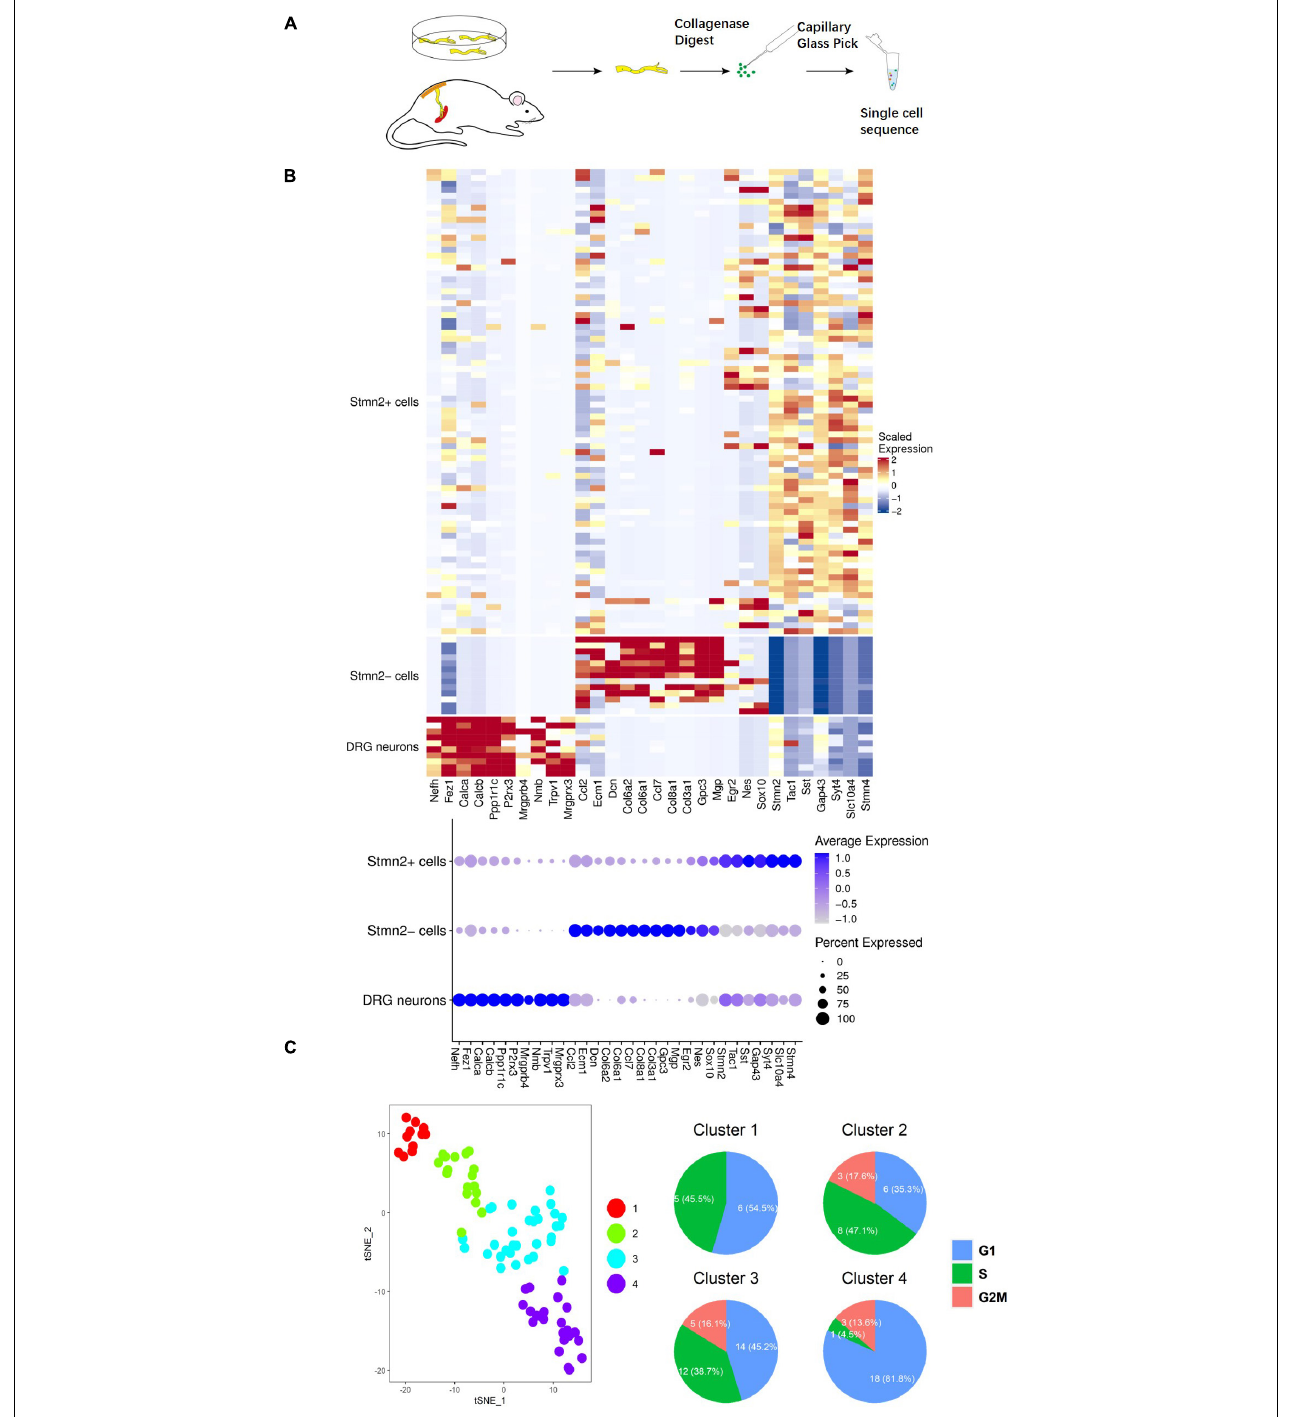
FIGURE 4 | Single-cell sequencing of the neuronal cells marked by AAV2/9 virus in sciatic nerves of adult rats. (A) Single cell acquisition model of virus-labeled neuronal cells. (B) Single-cell sequencing of virus-marked cells. Single-cell sequencing of neuronal cells was conducted after 2 weeks of hSYN -promoter AAV2/9 virus infection. The hot map represents the transcriptome similarities between 78 GFP + Stmn2 + cells, 13 GFP + Stmn 2 − cells, and 10 DRG cells. GFP + cells were dissected from nerves injected with hSYN -promoter GFP AAV2/9 virus. DRG neurons were dissected from adult rat DRGs in vivo . A total of 84 cells from cultured sciatic nerves, seven cells from virus-injected sciatic nerves in vivo , and 10 cells from DRG neurons. (C) t-SNE map represents the subcluster analysis of the 78 GFP + cells that expressed high levels of Stmn2 . The four colors represent four different clusters. The pie diagrams represented the cell cycle analysis of those cells. A total of 74 cells from cultured sciatic nerves and four cells from virus-injected sciatic nerves in vivo . See also Supplementary Figure 1 .